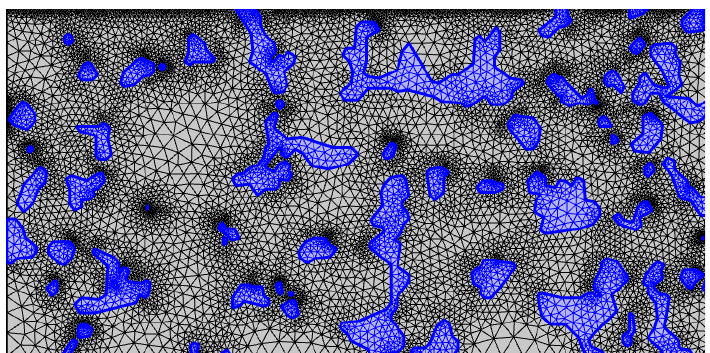
Figure 11. Model after meshing.